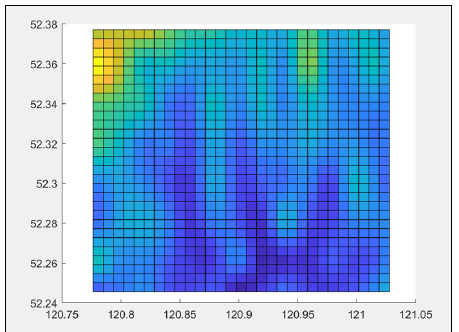
Figure 4. Rasterized view of the 3D model map.